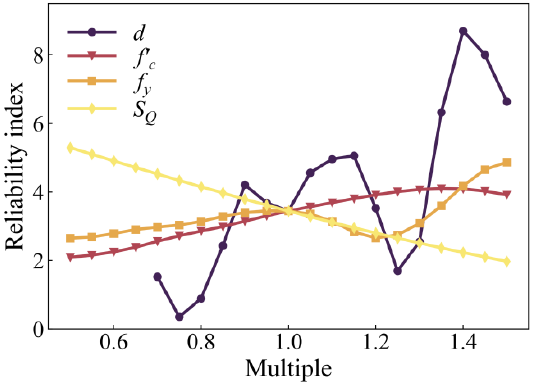
Figure 13. Impact of stochastic variables with different multiples on reliability index.